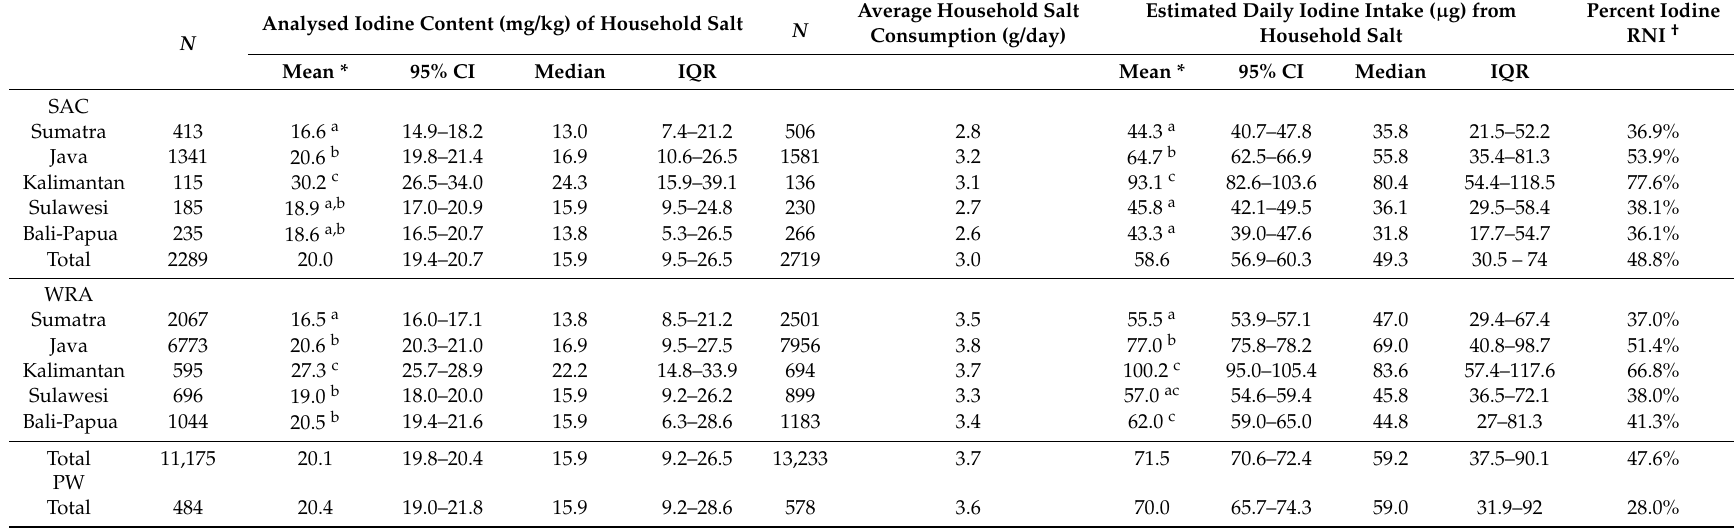
Table 7. Mean and median iodine contents of household salt (mg/kg) and estimated daily iodine intakes ( µ g) and percentages of RNI from household salt by